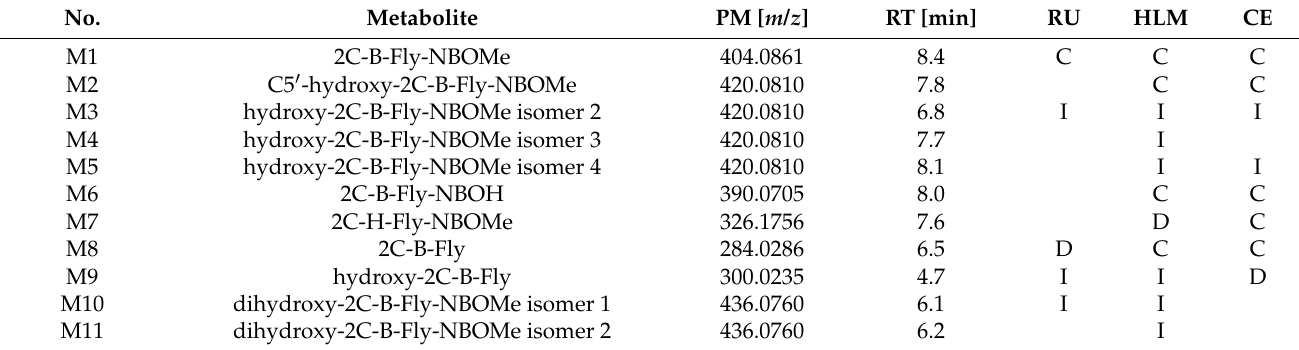
Table 2. 2C-B-Fly-NBOMe and its detected phase I and II metabolites: precursor ion exact masses (PM), retention times (RT), and detectability in rat urine (RU), human liver microsomes (HLM), and C. elegans culture medium (CE). Data was acquired by an UltiMate 3000 LC system (Thermo Fisher Scientific) combined with a hybrid TripleTOF 5600 mass spectrometer